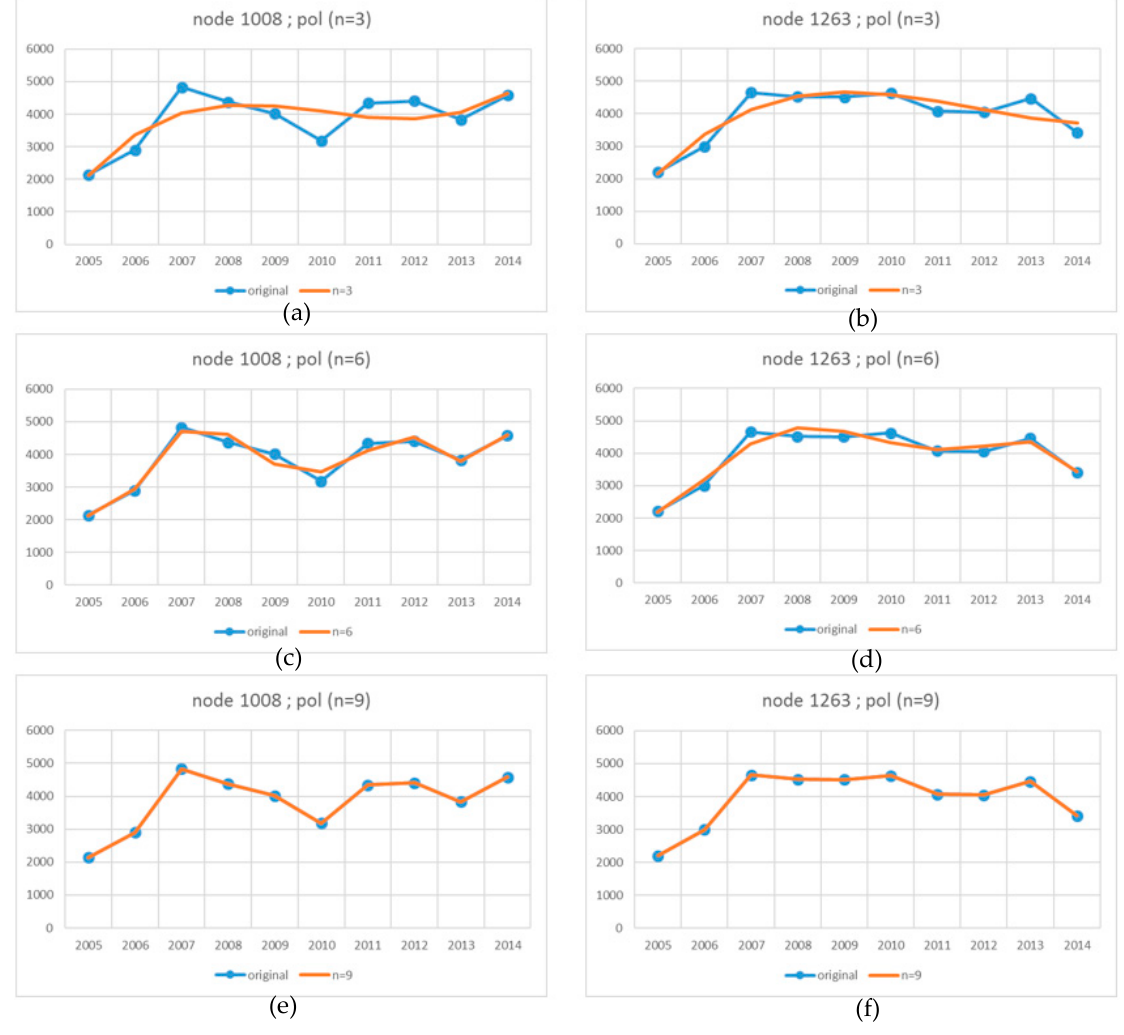
Figure 4. A comparison of changes in the original value and the value reconstructed in two selected nodes in successive measurement epochs for different degrees (n) of polynomials generated based on all the measurement epochs; ( a ), ( c ), ( e )—node 1008; ( b ), ( d ), ( f )—node 1263 (node location is shown in Figure 3b). Source: own elaboration.